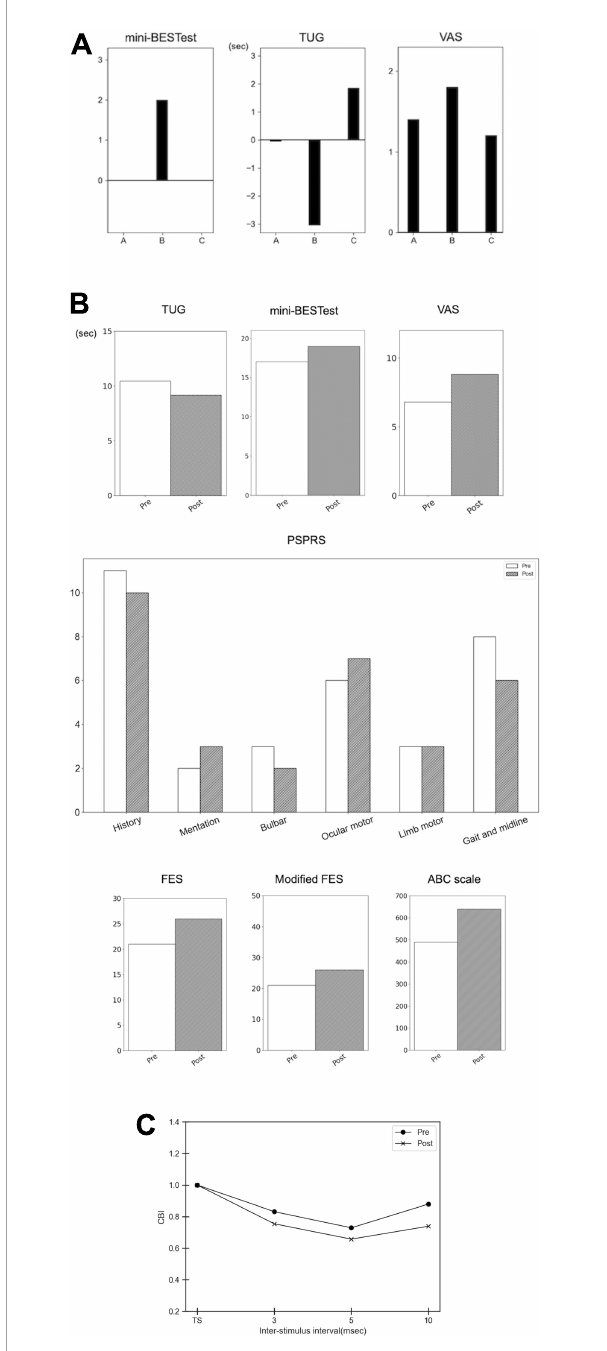
FIGURE2 Results of the short-term intervention, long-term intervention, and cerebellar brain inhibition. (A) Results of the short-term intervention. The bar graph demonstrates the difference in the pre- and post-intervention (subtraction of the scores, i.e., post-minus pre-interventions). Intervention A, sham stimulation; intervention B, gait-synchronized cerebellar tACS; and intervention C, gait-asynchronized cerebellar tACS. (B) Results of the long-term intervention. The bar graph demonstrates the scores of mini-BESTest, VAS, the time for TUG (seconds), the sub-scores of Progressive Supranuclear Palsy Rating Scale (PSPRS), Fall Efficacy Scale (FES), modified FES, and Activities-Specific Balance Confidence (ABC) Scale in the pre- and post-interventions. (C) Cerebellar brain inhibition (CBI). The X-axis shows the inter-stimulus intervals, and the Y-axis demonstrates the CBI. TS, test